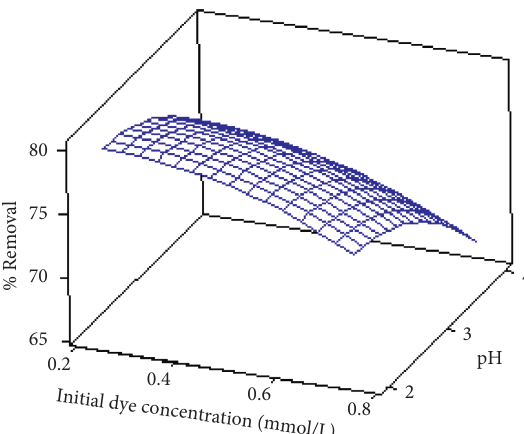
Figure 2: Residual plots for response yield.